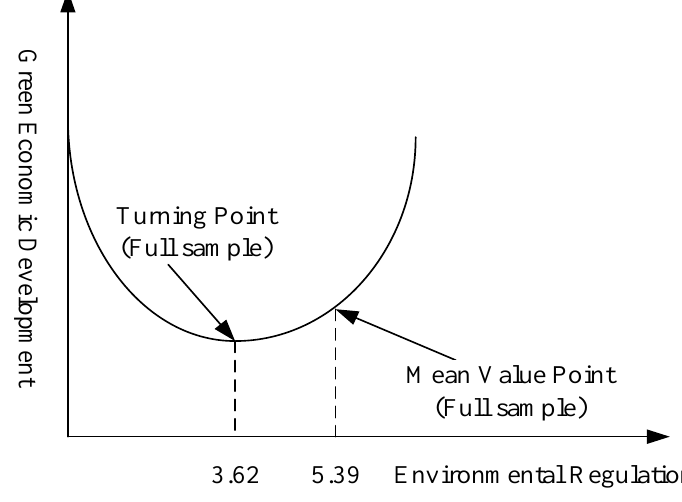
Figure 3. Nonlinear relationship between ER and GTFP (full sample).